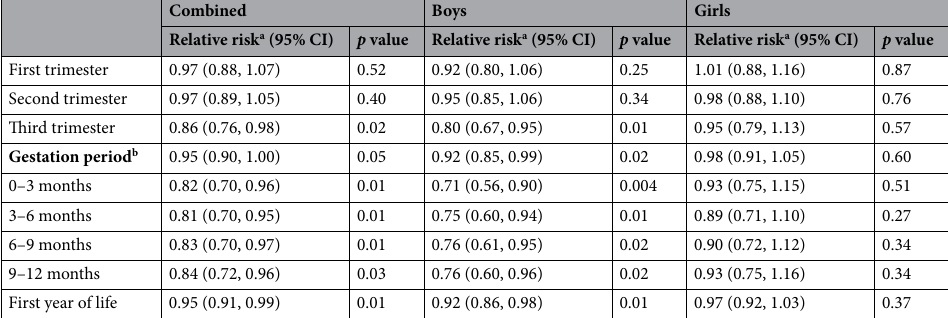
with type 1 diabetes risk (adjusted risk ratio (aRR) 0.86 per 100 kJ m −2 increase in total UVR dose, 95% CI 0.76, 0.98; p = 0.02). Higher total UVR dose in the first 12 months of life was associated with significantly lower type 1 diabetes risk in later childhood (Table 2). Neither total UVR dose during gestation nor the first year of life was associated with age of onset of type 1 diabetes. Whilst there was no significant interaction between sex and UVR for any period (p > 0.05 for each of the seven periods), analysis stratified by sex indicated a significant effect of UVR on type 1 diabetes risk in boys but not in girls. Among girls, total UVR dose was not associated with subsequent type 1 diabetes risk in childhood for any of the time periods investigated. However, among mothers of boys, higher total UVR dose in the third trimester was associated with significantly lower type 1 diabetes risk (Fig. 1). When third trimester total UVR dose was considered in quartiles, the risk of type 1 diabetes was 42% lower for the highest quarter compared to the lowest quarter (95% CI [2%, 65%]; p = 0.04). (Table 3; first and second trimester data shown in Table S1 and S2 respectively). Similarly, higher total UVR dose over the first 12 months of life was associated with a sig- nificantly lower risk of type 1 diabetes among boys; this effect was most pronounced for the first three months post-birth (Table 2). For every 100 kJ m −2 increase in total UVR dose, the relative risk of type 1 diabetes among boys decreased by 29% (total UVR dose ranged from 75.8 kJ m −2 to 723.9 kJ m −2 ) (Fig. 1). An interaction analysis indicated that there was no significant variation in effect of UVR by age at diagnosis (gestation p = 0.15; first year of life p = 0.34).